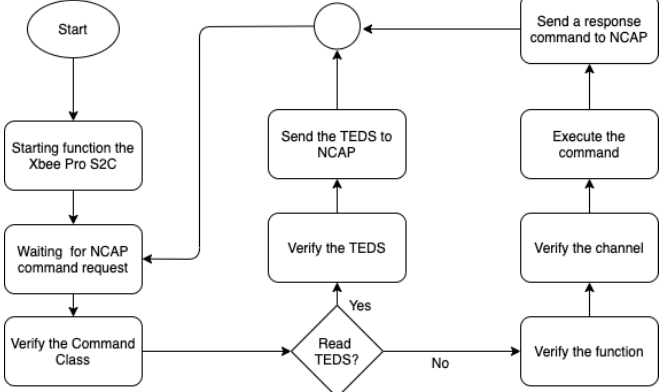
Figure 6. Flowchart of the logical part of